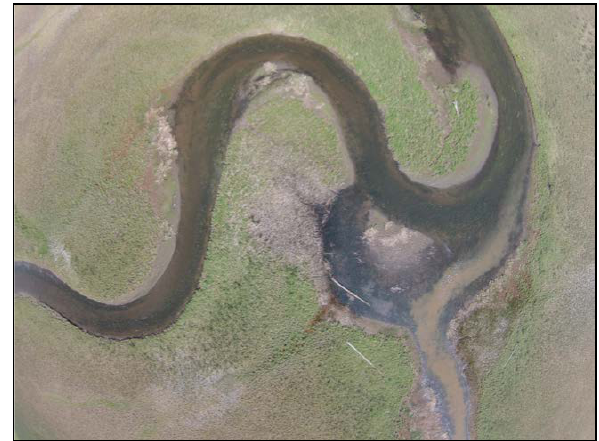
Figure 3. Sample image from the DJI Phantom 2 Vision+ wide- angle camera, flying 90 metres above ground